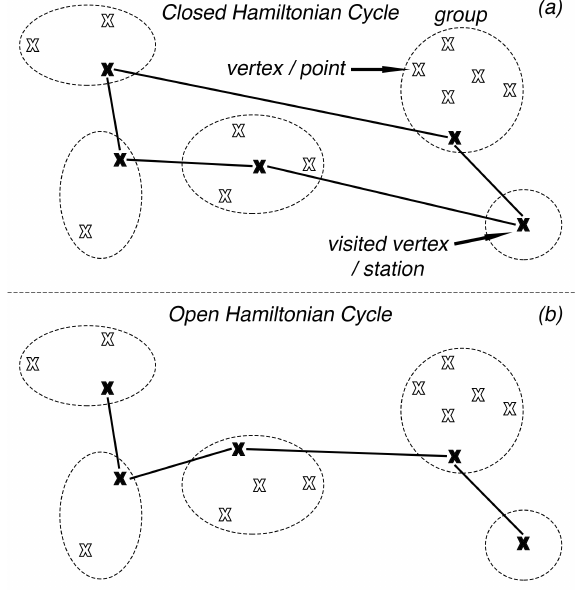
Figure 1. Representation of one possible ( a ) closed and ( b ) open Hamiltonian cycle in a given symmetric E-GTSP instance. Here, the group-counts are equal to 5, and the total number of vertices are equal to 16; in other words, x = 5 and n = 16,